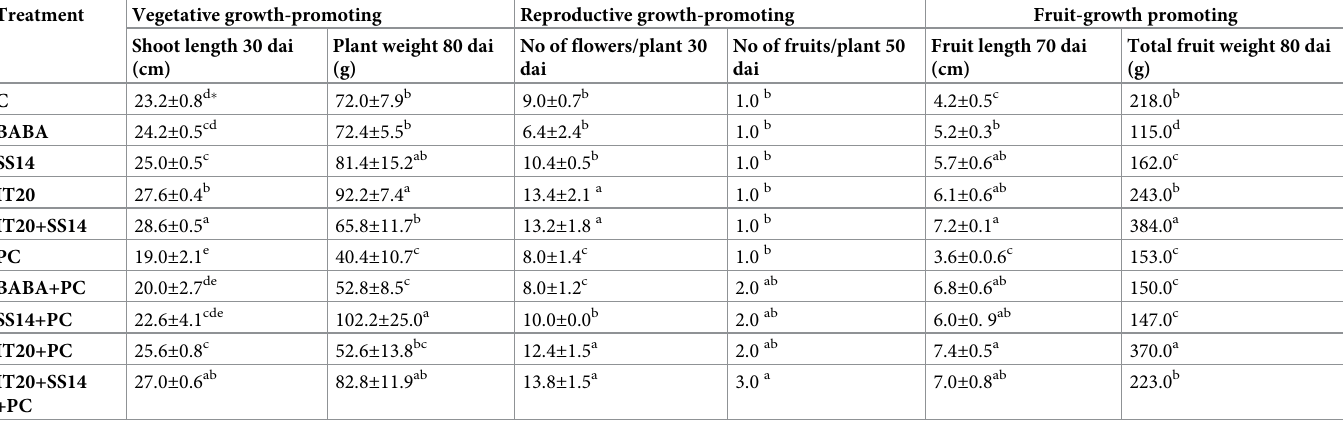
Table 2. Effect of bacterial treatments and beta aminobutyric acid (BABA) on growth and bio-suppression of pepper blight disease caused by Phytophthora capsici ( PC ). Treatment Vegetative